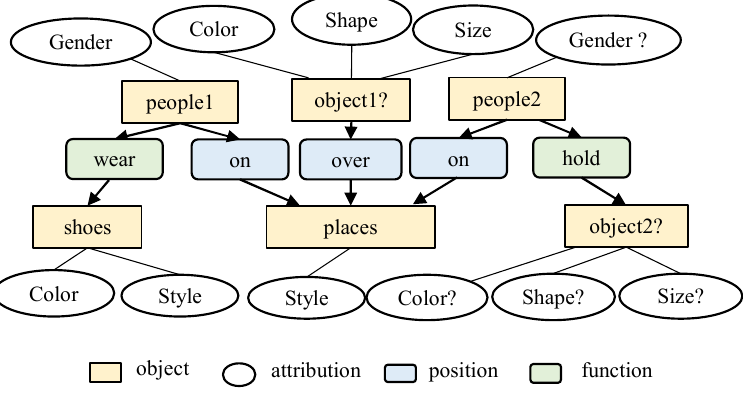
Figure 3. The knowledge subgraph of Figure 1. Two types of relationships are defined in knowledge subgraph. R 1 is the set of positional relationships and R 2 is the set of functional relationships, where R 1 ∪ R 2 = R , R 1 ∩ R 2 = φ . Figure 3 shows the knowledge subgraph of Figure 1. In this example, the object instances and their attributions are shown in Table 1. The relationships between instances are shown in Table 2. Table 1. The object instances and their attributes in Figure 1.